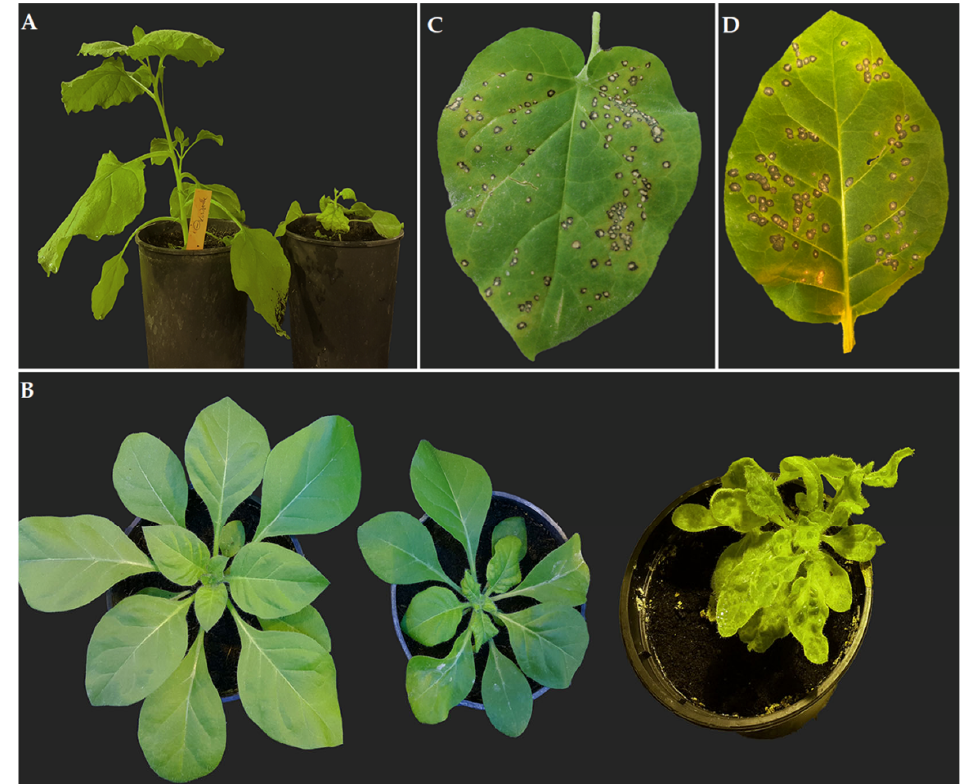
Figure 1. ToBRFV-induced symptoms on Nicotiana spp. after mechanical inoculation. ( A ) Severe stunting of N. benthamiana (left: mock-inoculated, right: ToBRFV-inoculated). ( B ) Left plant: mock-inoculated, Middle plant: early stunting and deformation of ToBRFV-inoculated N. clevelandii, Right plant: development of deformation and mosaic to the entire N. clevelandii plant. ( C ) Necrotic local lesions on N. glutinosa and ( D ) necrotic local lesions on N. tabacum cv. Xanthi nc.